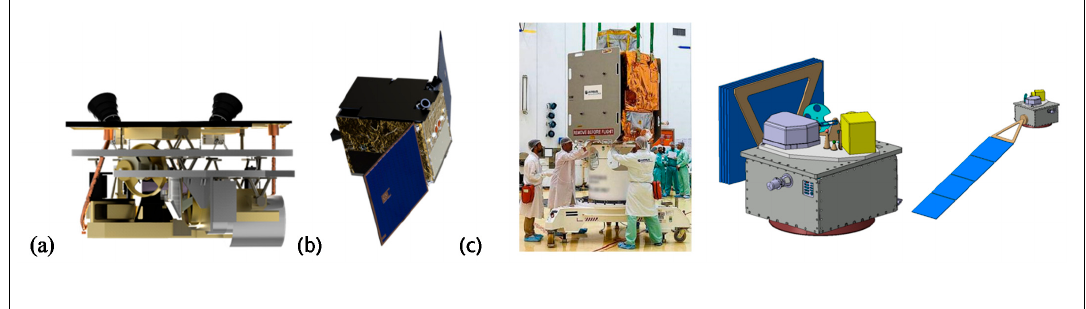
Figure 16. Images of possible platforms and payload integration: ( a ) payload integrated on SSTL Formosat 7 platform, ( b ) Formosat 7 candidate platform, ( c ) Peru-Sat1 on Airbus Astrobus-S (baseline platform for TRUTHS), ( d ) TRUTHS payload configured on Astrobus-S.